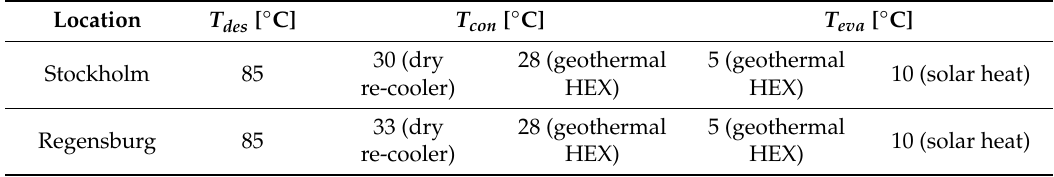
Table 5. Reference STES boundaries for Regensburg and